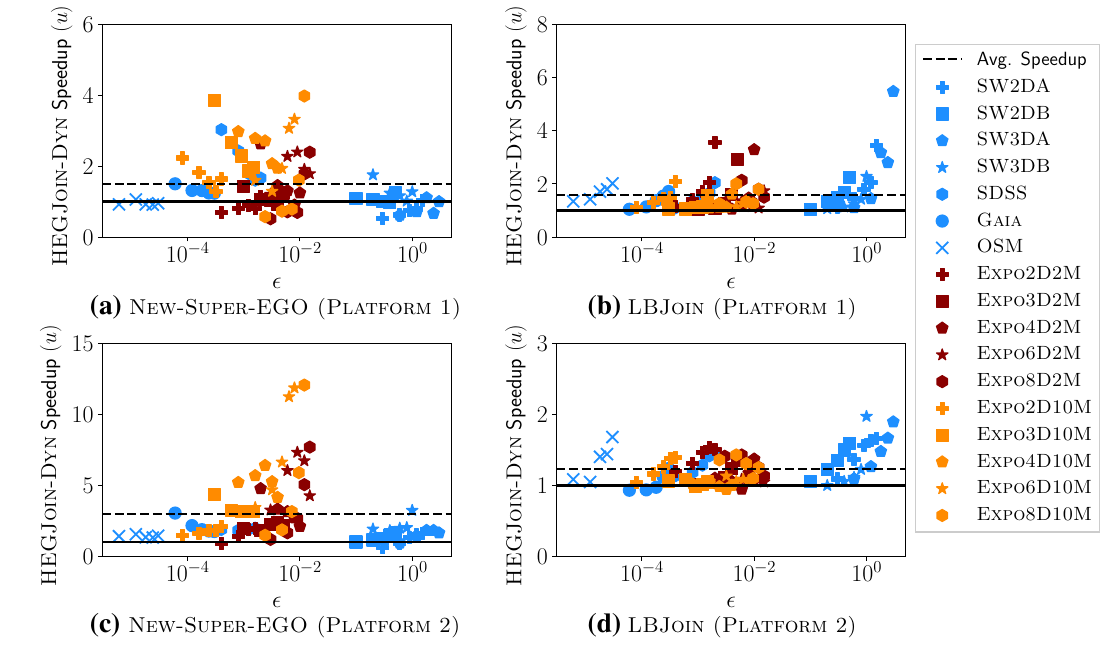
Fig. 13 Average speedup of HEGJ oin -d yn over a n Ew -S upEr -EGo and b LBJ oin on Platform 1, and over c n Ew -S upEr -EGo and d LBJ oin on Platform 2, across all datasets (Table 2). The horizontal